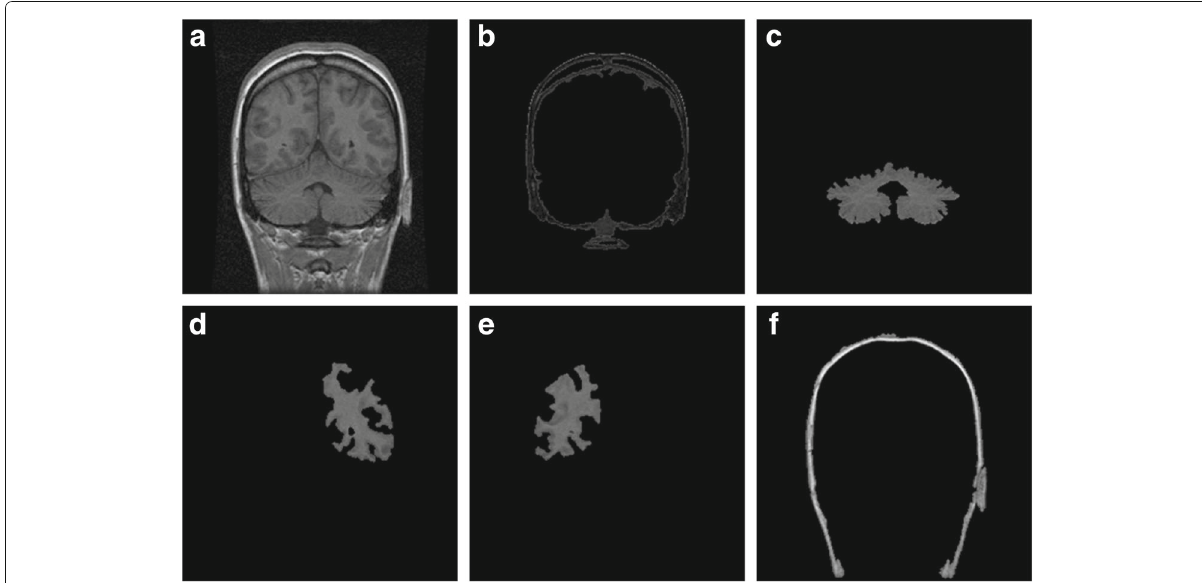
Fig. 7 Segmentation processes for the other frames: a the 14th MR image, b–d segmented parts, e the 50th MR image, f–h segmented parts, i the 67th MR image, and j–l segmented parts